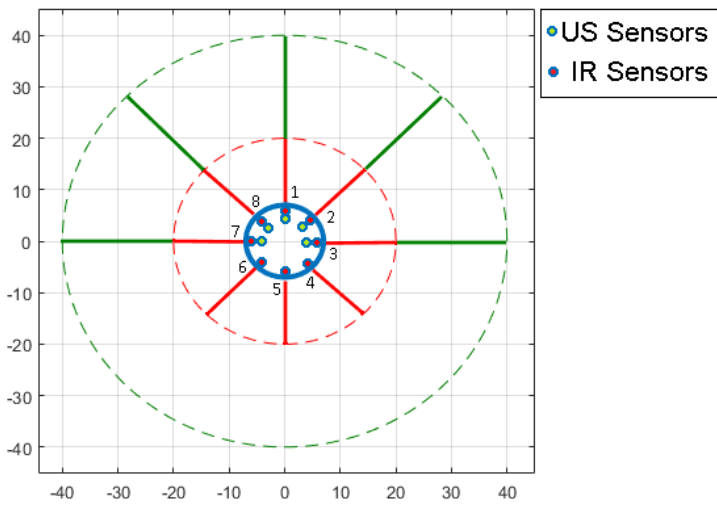
Figure 1. Khepera IV robot sensors distribution.